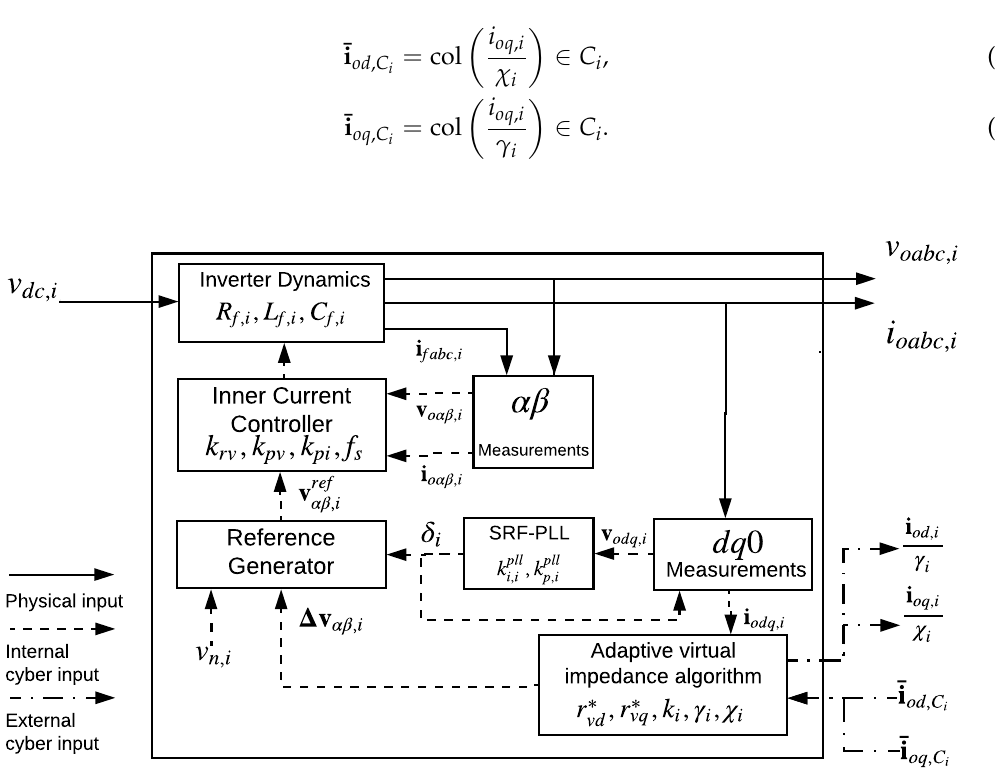
Figure 10. IDG CPES module (Cooperative-Adaptive SRF virtual impedance